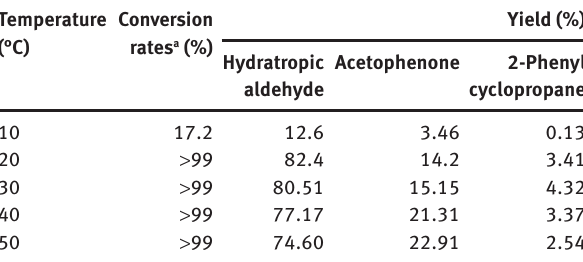
Table 2: The influence of reaction temperature. Temper ature